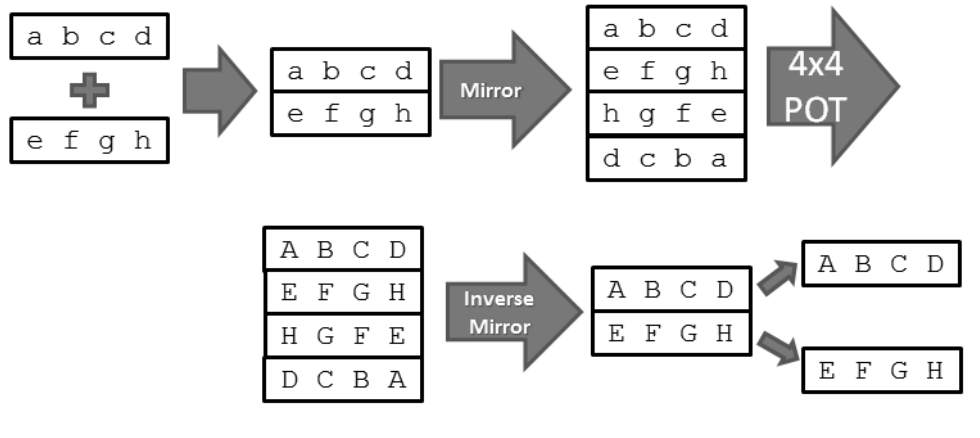
Figure 21. Using 4 × 4 POT instead of 4 × 1